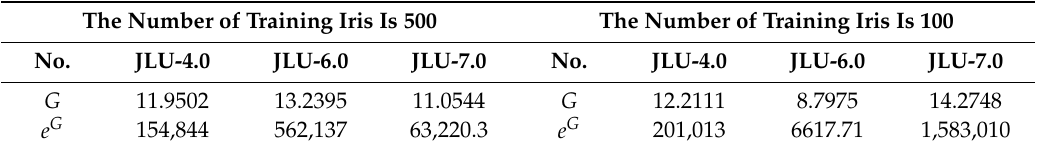
Table 12. The entropy feature G and enlarging value e G